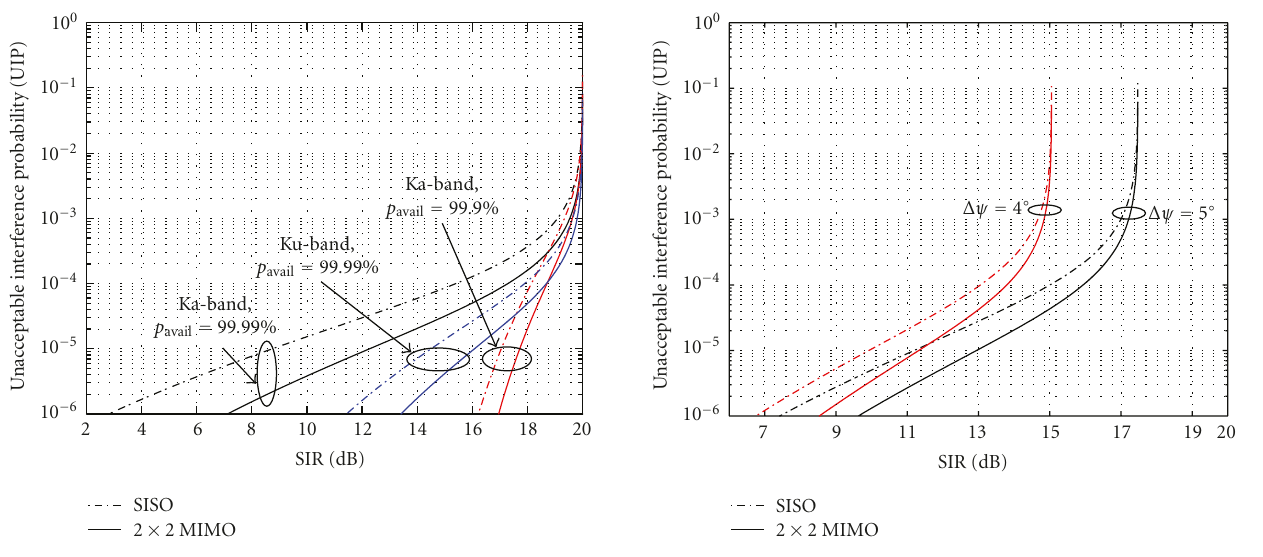
Figure 9: UIP versus SIR for a satellite 2 × 2 MIMO diversity sys- tem employing receive antenna selection. Relevant SISO case is also plotted for comparison. E ff ect of angular separation ΔΨ